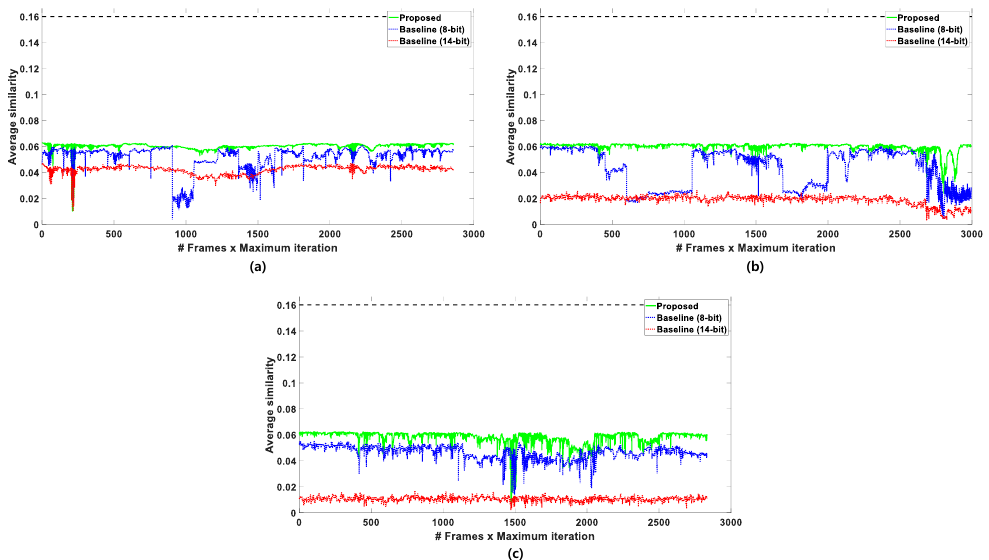
Figure 11. Histogram average similarity of each video sequence: ( a ) average histogram similarity. Sequence ( a , b ), average histogram similarity ( b , c ), average histogram similarity ( c